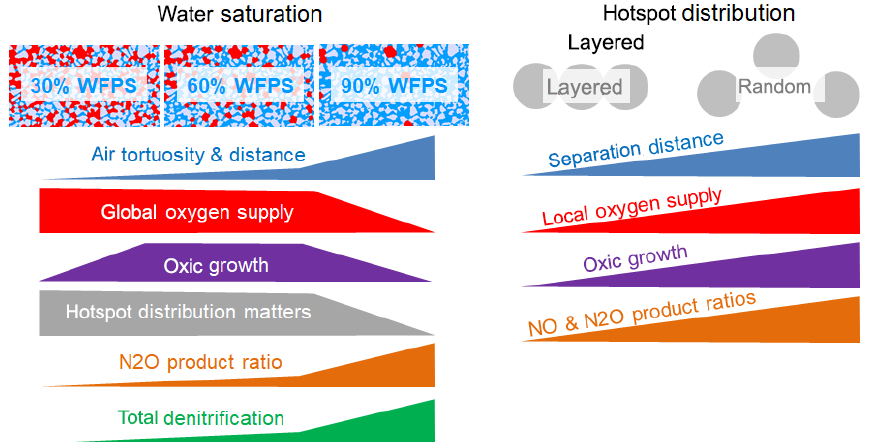
Figure 7. Summary of the experimental findings about the impact of water saturation and spatial hotspot distribution on the physical con- straints on the supply of hotspots with oxygen, the resulting growth rates and the implication of various aspects of